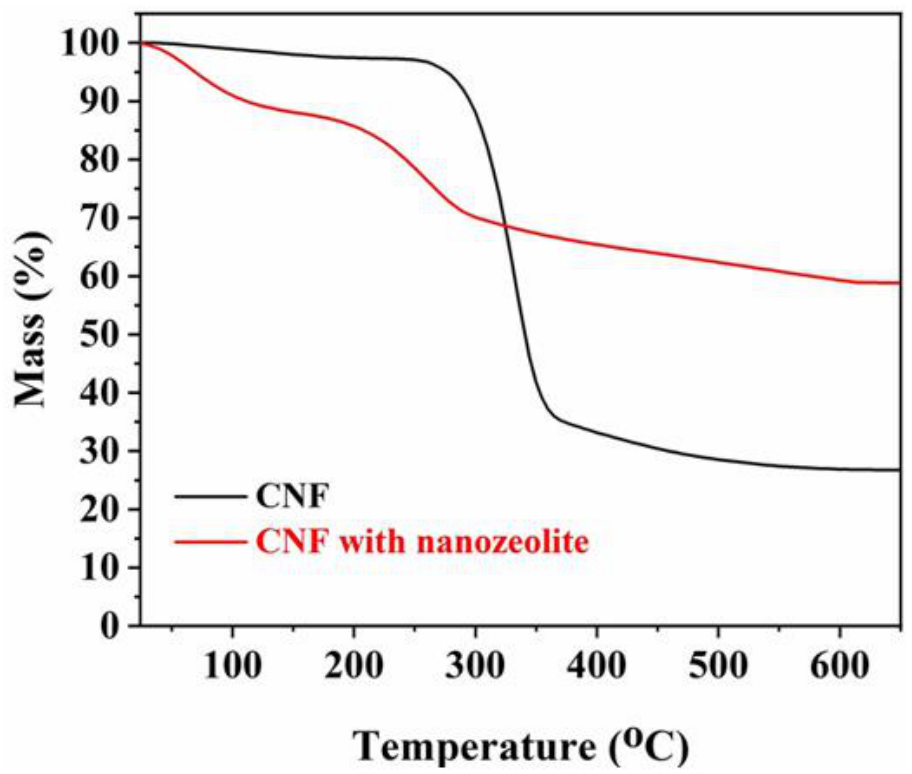
Figure 8. TGA thermograms of CNF and the mixture of ball-milled zeolite with CNF before calci- nation.